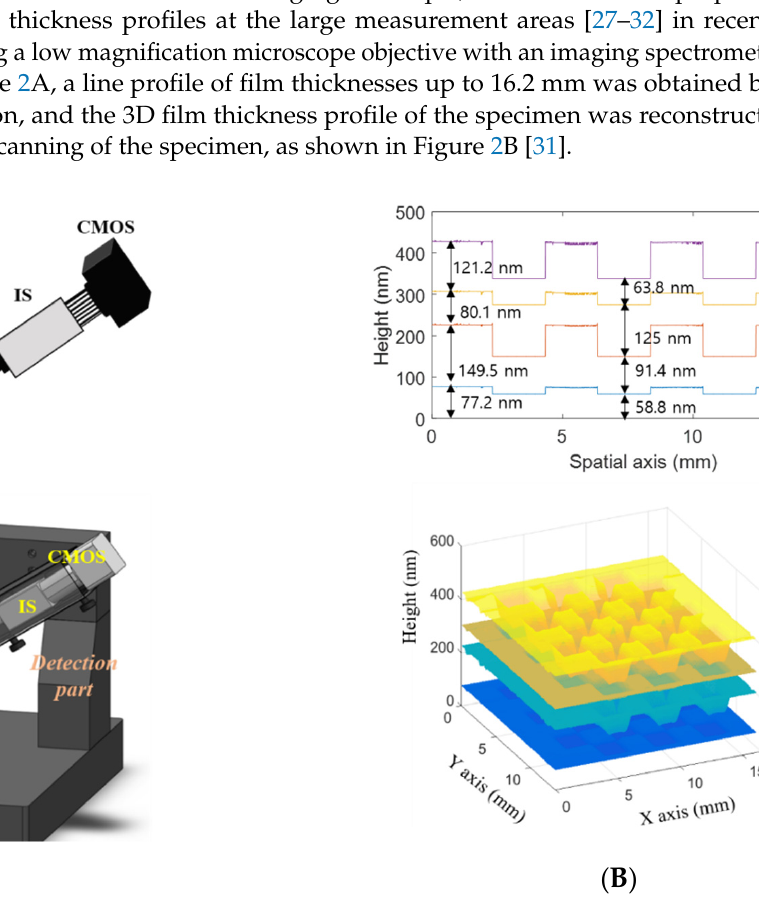
Figure 2. ( A ) Optical configuration of spectroscopic imaging ellipsometry and ( B ) its multi ‐ layered film characterizations originated from Ref. [31]; BE, a beam expander; P, a polarizer; C R , a rotating compensator; A, an analyzer; S, a specimen; IL, an imaging lens; IS, an imaging spectrometer. In addition, a non-collimated beam was used to illuminate the specimen in SIE [36], and the 3D film thickness profile was obtained at once in PSA-type ellipsometry. In this research work, a wide-angle imaging ellipsometric configurations as shown in Figure 3A, respectively, were proposed, and the thickness profiles of various SiO 2 film layers were reconstructed as shown in Figure 3B. However, the lateral resolution was determined by the angular resolution limited by the exit pupil of the system, and it was 0.5